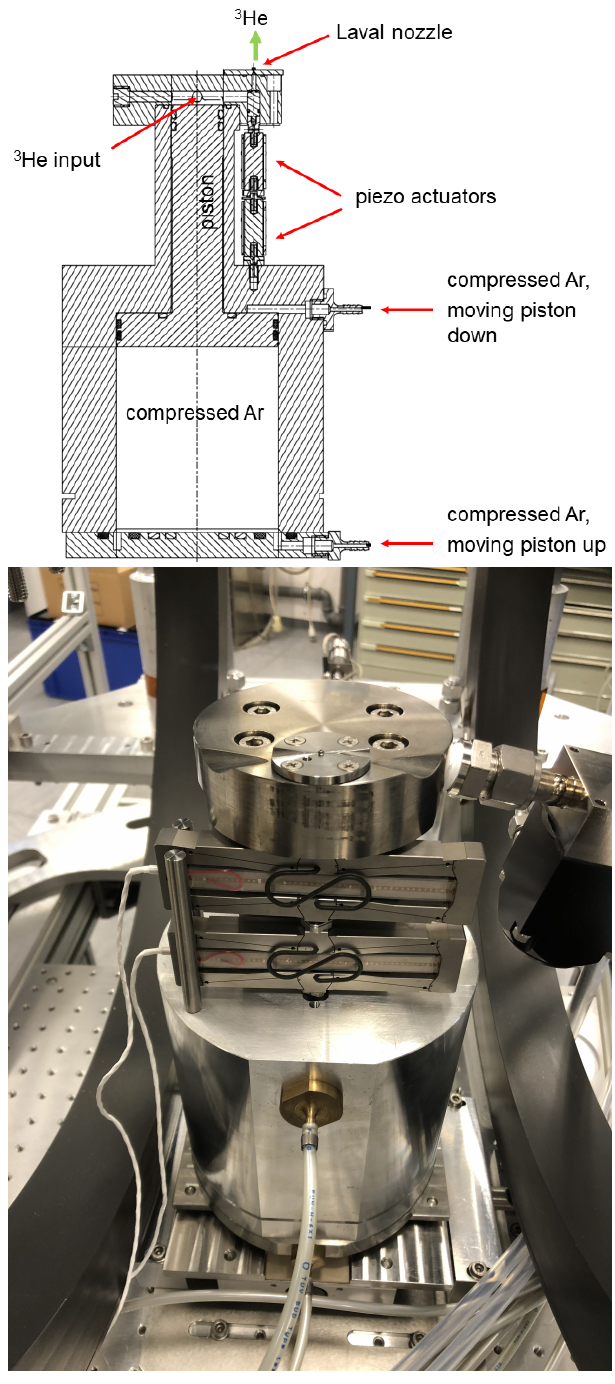
Figure 6. Top: Drawing of the compressor unit (edited figure from Ref. [34]). The piston is in the upper position, i.e., the 3 He gas is compressed. Bottom: Photo of the compressor unit with the nozzle mounted on the